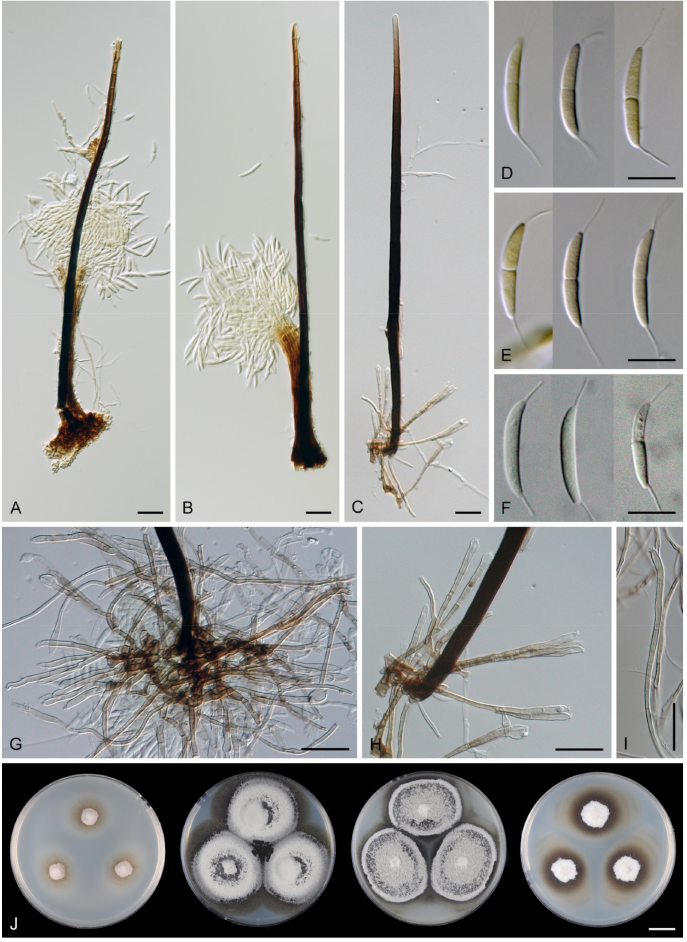
Figure 3. Arcuatospora seorsa . ( A – C ) setae with synnemata ( D – F ) conidia ( G , H ) base of the seta with conidiophores ( I ) conidiophore (J ) colonies on CMD, MLA, OA and PCA after 4 weeks (from left to right). Images: ( A , B , D , E , J ) CBS 147510 ex-type; ( C , F – I ) CBS 147509; ( A , B , D , E ) from nature; ( C , F – I ) on PCA after 4 weeks. Scale bars: ( A – C , G – I ) 20 µ m; ( D – F ) 10 µ m; ( J ) 1 cm. Characteristics in culture: On CMD colonies 14–16 mm diameter, circular,